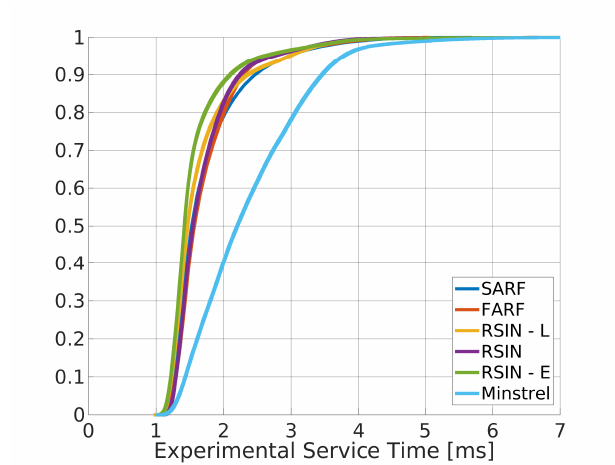
Figure 6. ECDFs for the comparison of the RTT when rate adaptation is enabled.